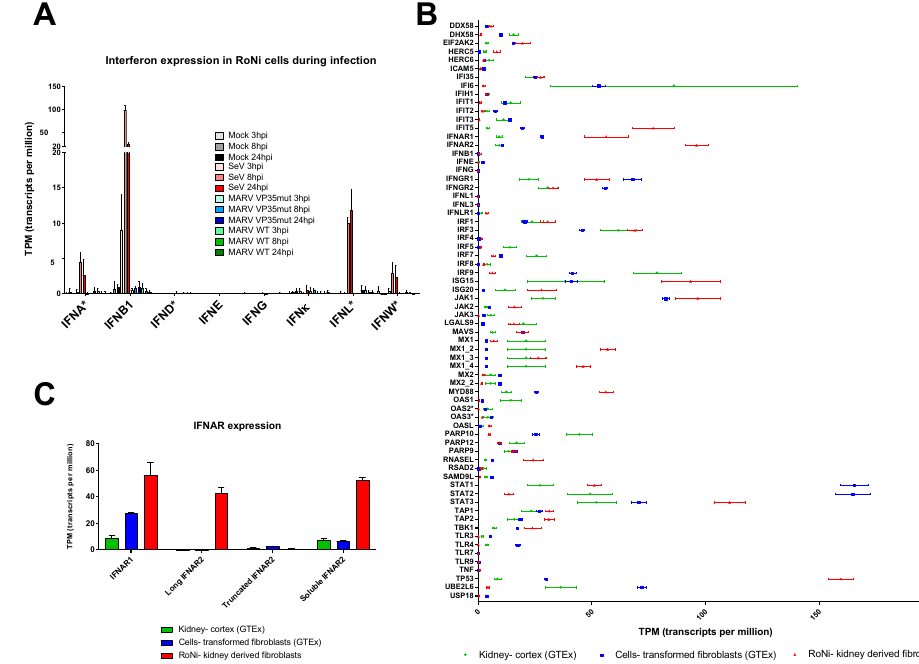
Figure 5. The IFN gene induction and baseline expression of innate immune genes. ( A ) The IFN gene induction in RoNi cells during infection. Transcripts per million (TPM) were graphed for each time point and infection condition. Error bars represent SD of three biological replicates. IFNs labeled with an * indicated aggregated expression of all subtypes. This includes the 12 IFNA subtypes, 22 IFNW subtypes, and 9 IFND subtypes. IFNL has not been annotated in the rousette genome, so this value represents the aggregation of LOC107520937, LOC107521776, LOC107520939, LOC107520938, and LOC107521777, all termed to be “ IFNL -like” genes. ( B ) Samples include RoNi Mock cells (9 replicates) compared to transformed fibroblasts (343 replicates) and kidney-cortex cells (45 replicates) from the GTEx database. Outliers in the datasets were removed if the value fell beyond 2.5 SDs from the mean. Points represent the mean and the error bars correspond to SD. ( C ) Isoform expression of IFNAR variants is shown. Same datasets as in ( B ). Isoforms falling into the categories of long, truncated, and soluble were aggregated and plotted. Starred genes correspond as follows: OAS2: LOC107501264; OAS3: LOC107513228; MX1: LOC107498547; MX1_2: LOC107504926; MX1_3: LOC107507190; MX1_4: LOC107507192; MX2: LOC107507191; MX2_2: LOC107507193; IFNL1: LOC107521777; IFNL3: